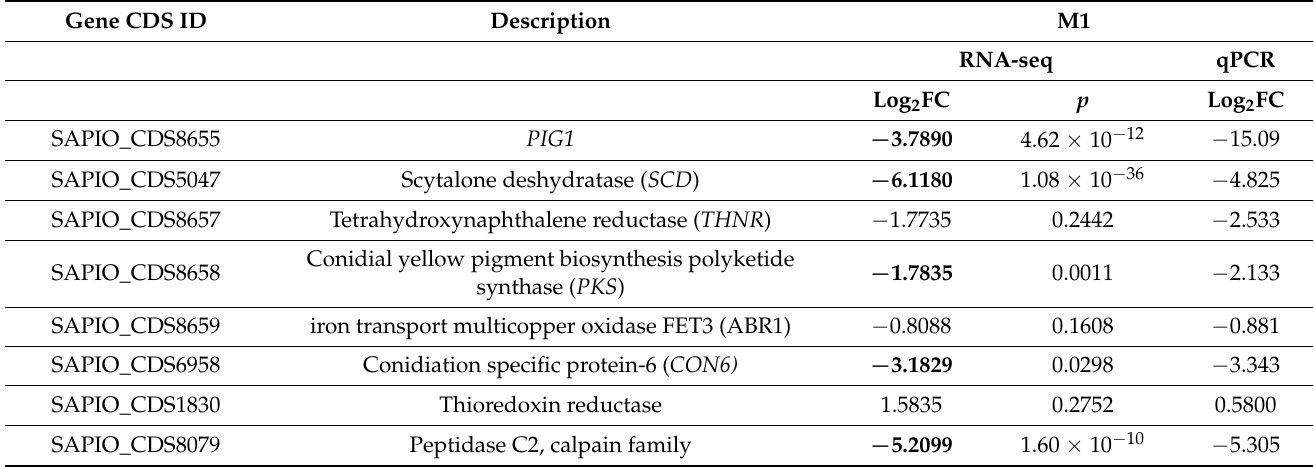
Table 2. qPCR validation of RNA-seq results on selected genes.